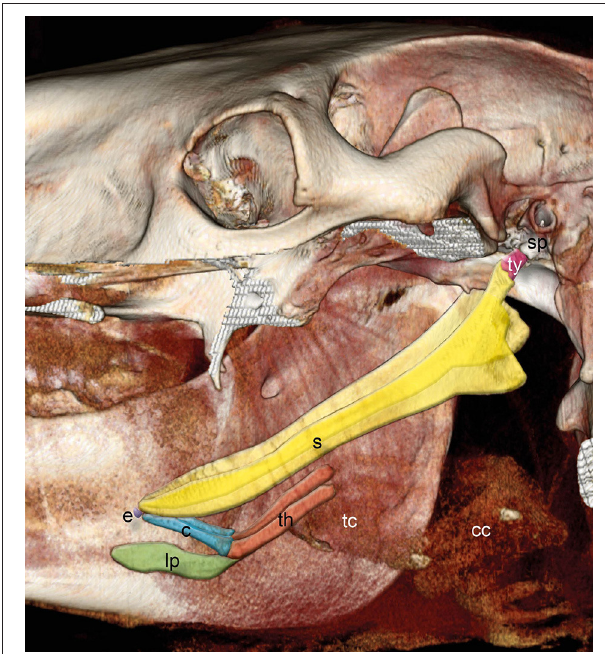
FIGURE 1 | Three-dimensional (3D) reconstruction of an equine skull retrieved from CT images with the left mandible and parts of the left upper jaw removed. Images acquired in the soft tissue algorithm. The styloid process (sp) of the temporal bone is connected via the tympanohyoid (ty) to the stylohyoid bone. Stylohyoid (s), epihyoid (e), ceratohyoid (c), lingual process (lp), and thyrohyoid (th) are indicated. Thyroid cartilage (tc) and cricoid cartilage (cc) could hardly be